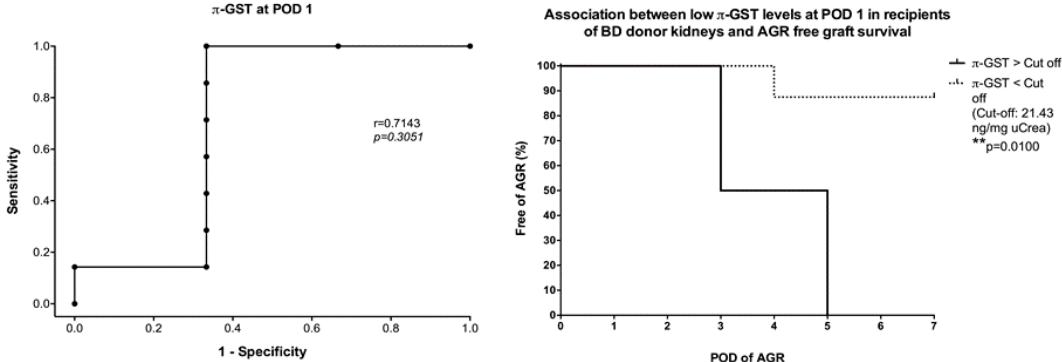
Figure 4. Correlation between urinary π -GST levels in recipients of brain-dead donors’ grafts on POD 1, and probability of graft survival without acute graft rejection (AGR) during the first week after transplantation.